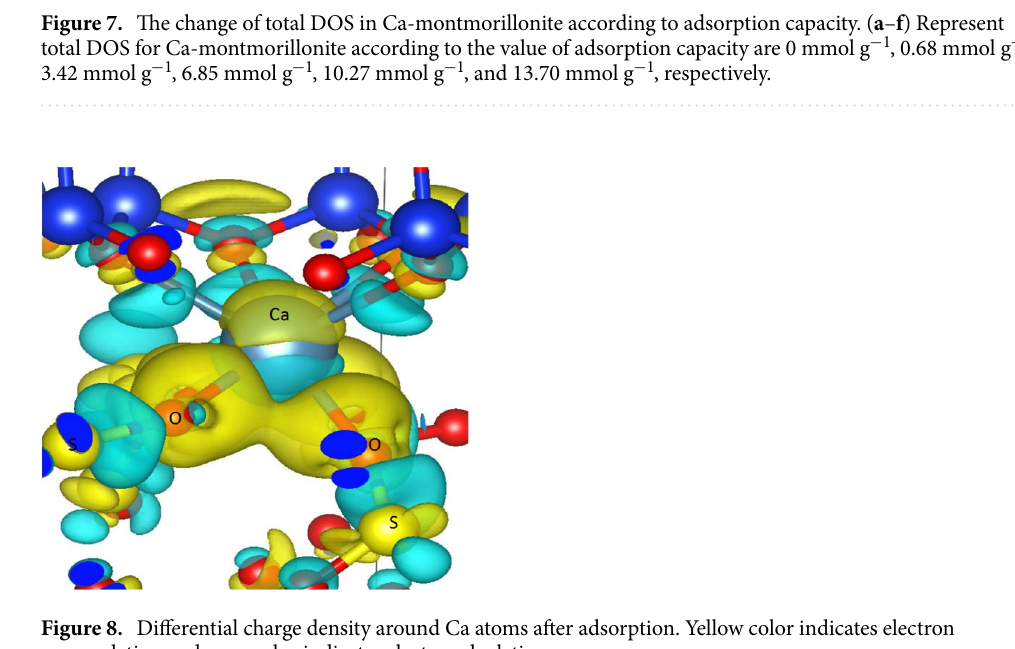
Figure 7. The change of total DOS in Ca-montmorillonite according to adsorption capacity. ( a – f ) Represent total DOS for Ca-montmorillonite according to the value of adsorption capacity are 0 mmol g −